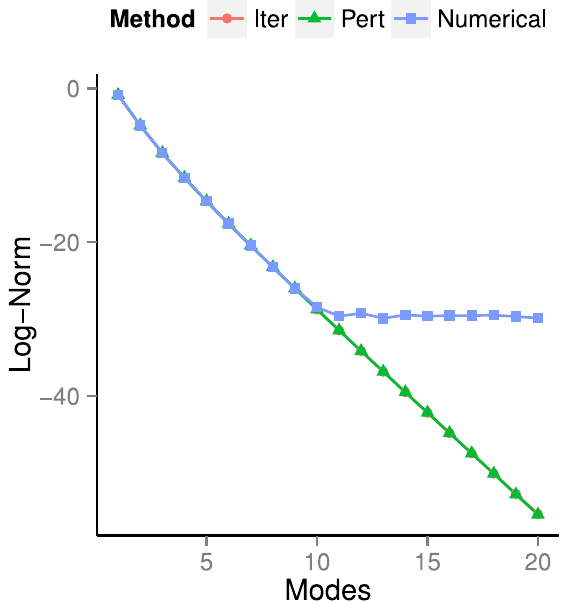
Figure 7. Decay of Fourier coefficients. We plot log E a k E versus k to illustrate the decay of Fourier coefficients for the three methods. The iterative and perturbative curves coincide and are nearly linear with slope { 2 : 8004 ; the exponential decay of these Fourier coefficients is consistent with theory. The time integrator’s Fourier coefficients do not decay after mode 10 , violating the theoretical decay rate.